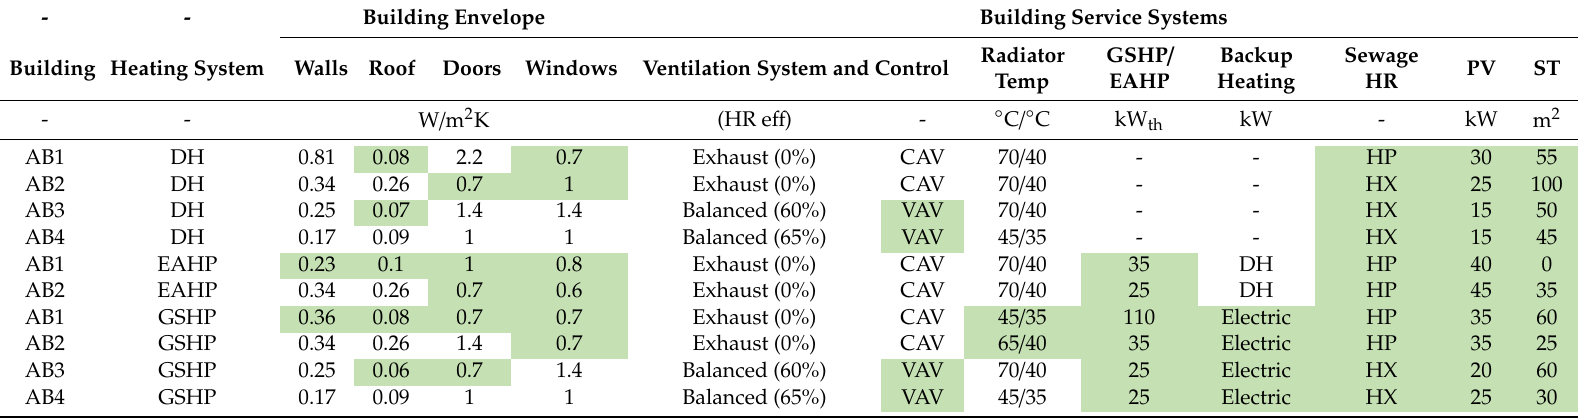
Table 3. Properties of the service buildings.